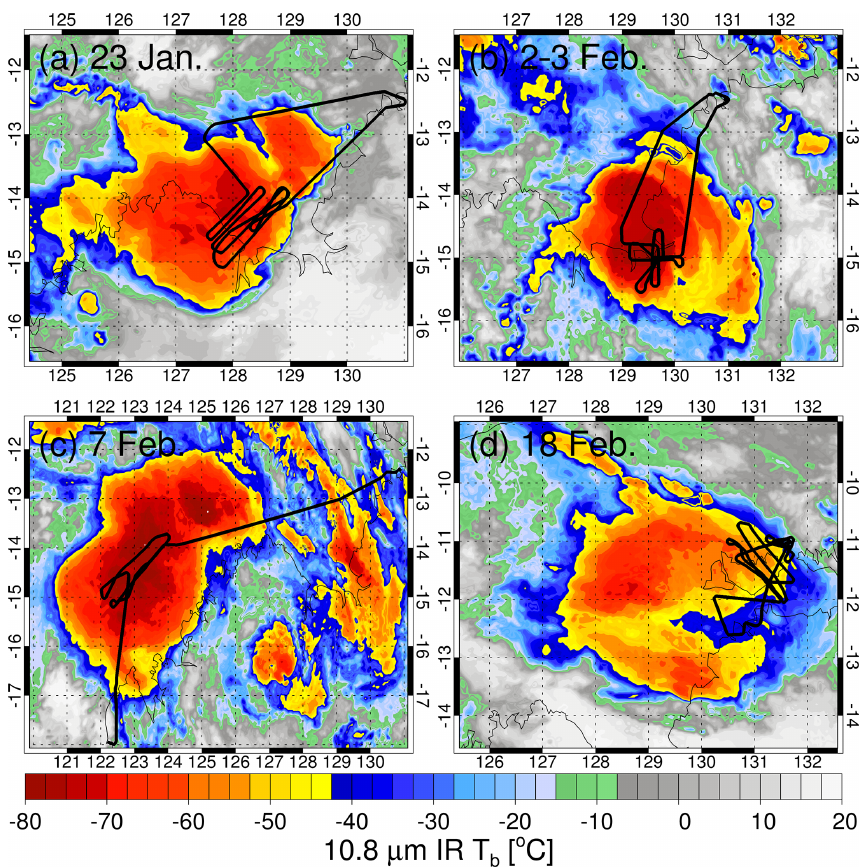
Figure 1. Flight tracks (black lines) for (a) Flight 6 on 23 January 2014, (b) Flight 13 on 3 February 2014, (c) Flight 16 on 7 February 2014, and (d) Flight 23 on 18 February 2014 overlaid on IR imagery from MTSAT-1R during flight sampling. Note that both flights 12 and 13 flew through the same system (2–3 February), but only Flight 13 is